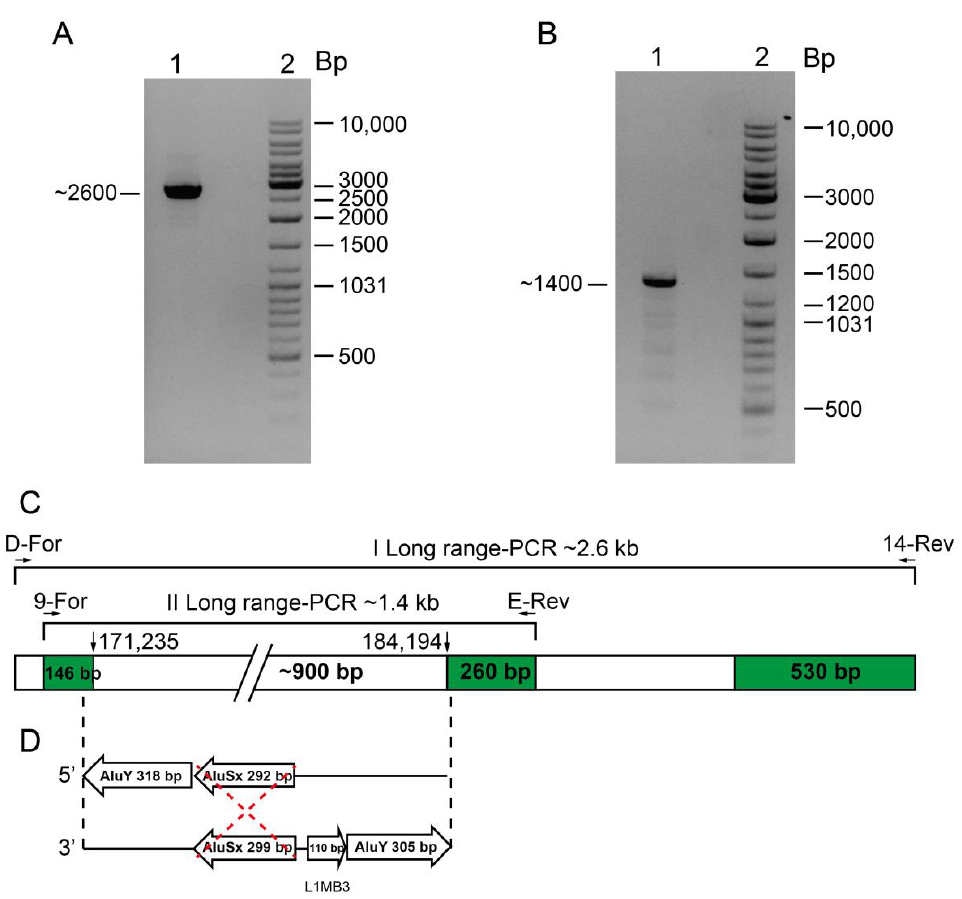
Figure 3. Molecular characterization of the --FG deletion. ( A and B ) Product of the long-range GAP-PCR separated on new-Sieve agarose gel. Line 1: carrier of the --FG deletion; line 2: ladder. ( C ) Scheme of the sequencing analysis of the amplicons. In the upper part have been reported the oligos and the length of the amplicons. Green boxes indicate the sequenced regions, white boxes the un-sequenced regions. The number close to the vertical arrow refer to the last sequenced positions on the chromosome. ( D ) Probable breakpoint. The boxes with arrows indicate the repeated sequences and the orientation located, respectively, at 5′ and 3′ of the breakpoint. The red dotted lines indicate the possible recombinant event.